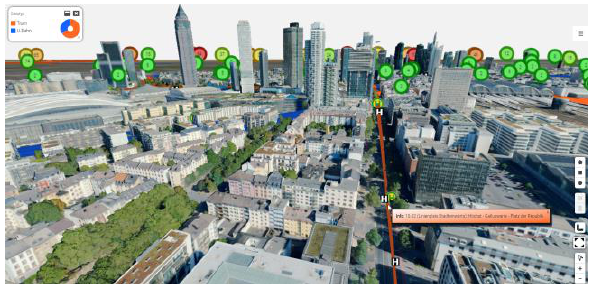
Figure 2 : 3D Mesh, downtown Frankfurt, from CityMapper-2 hybrid sensor data. with transportation information